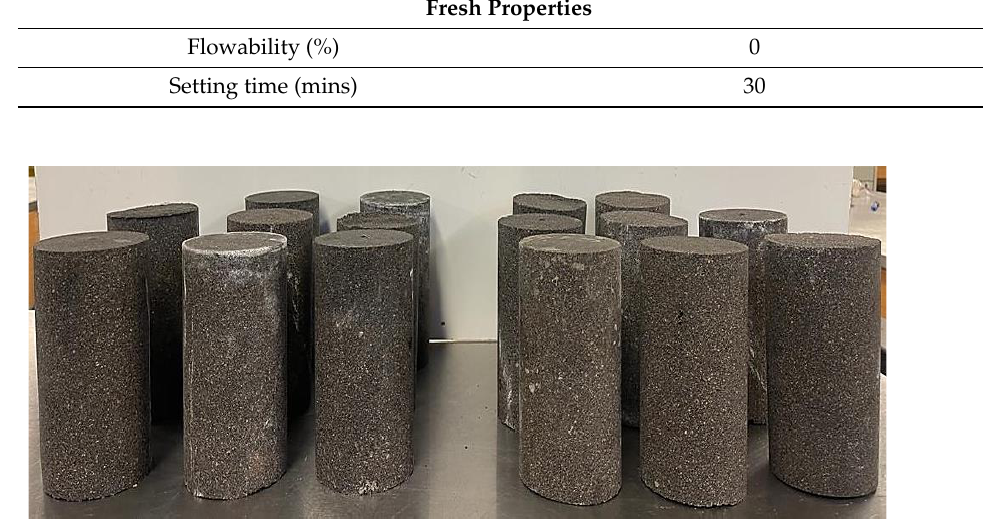
Table 3. Flowability and setting time for BPC.